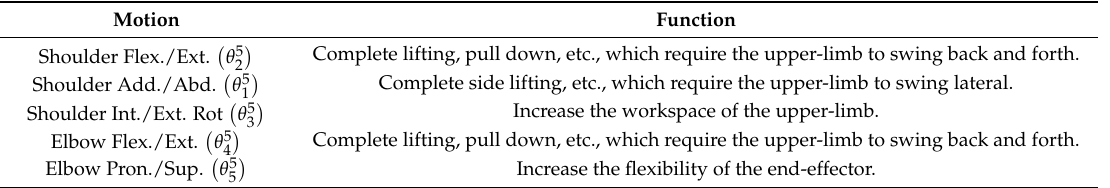
Table 3. Function of the DOFs of the 5-DOF upper-limb exoskeleton.